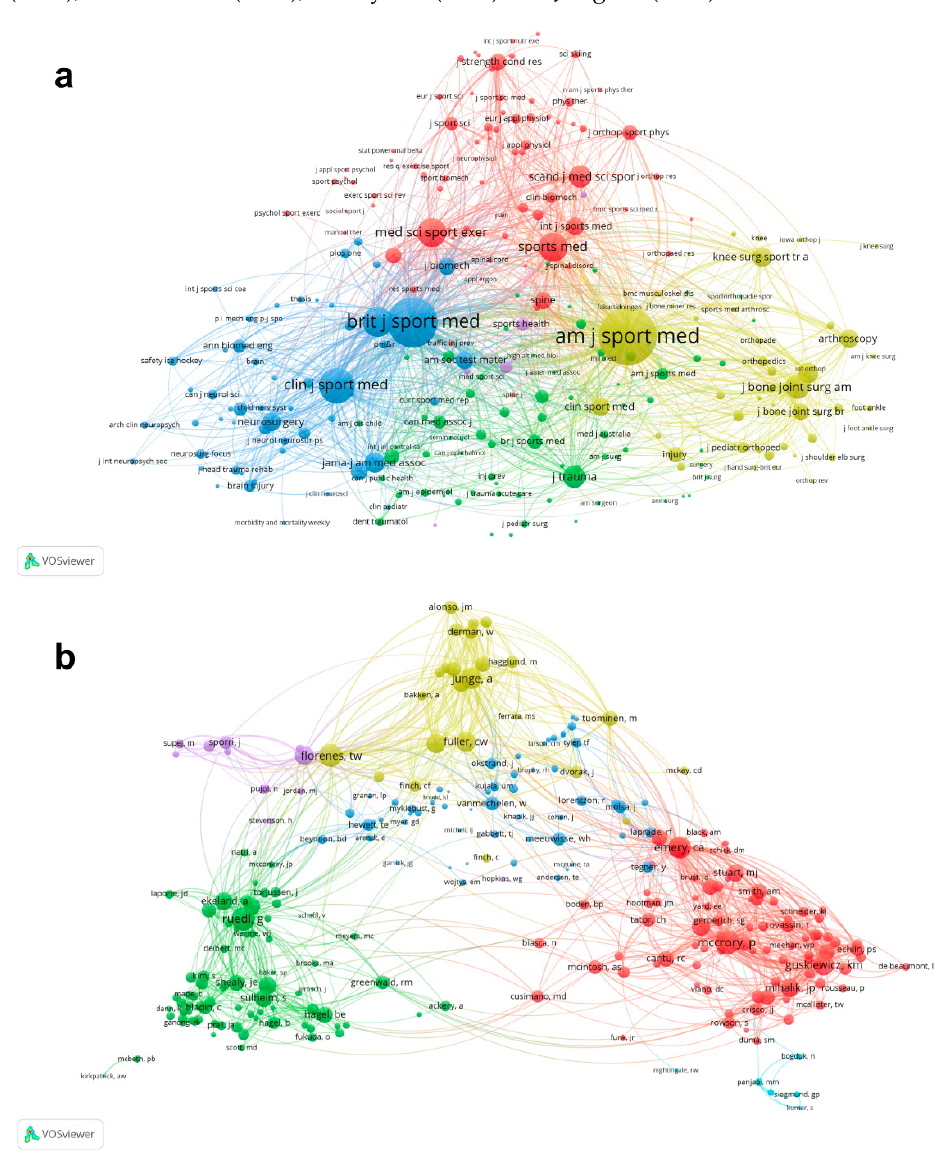
Figure 6. Co-citation analysis of global research about ice and snow sports injuries. ( a ) Network visualization mapping for the 256 identified journals. ( b ) Network visualization mapping for the 260 identified authors. The size of the nodes indicates the frequency of citation. Lines between two nodes indicate that two articles were cited together by other documents.